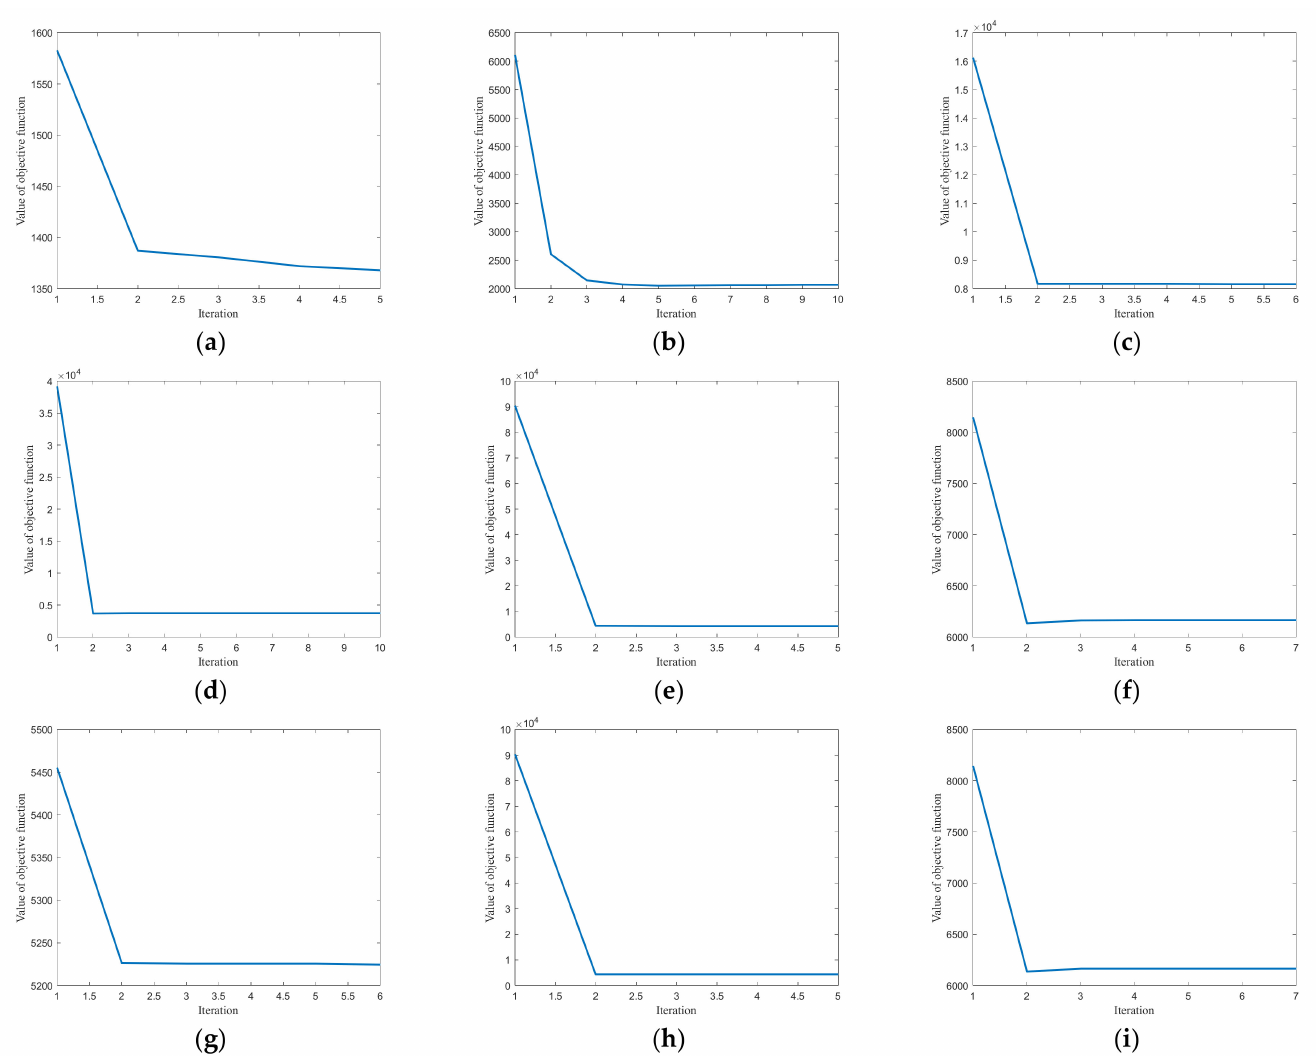
Figure 5. Convergence performance on nine multi-view data sets. ( a ) 3sources, ( b ) 100leaves, ( c ) BBC, ( d ) Caltech101, ( e ) COIL-20, ( f ) NottingHill, ( g ) Webkb, ( h ) Cornell, ( i )